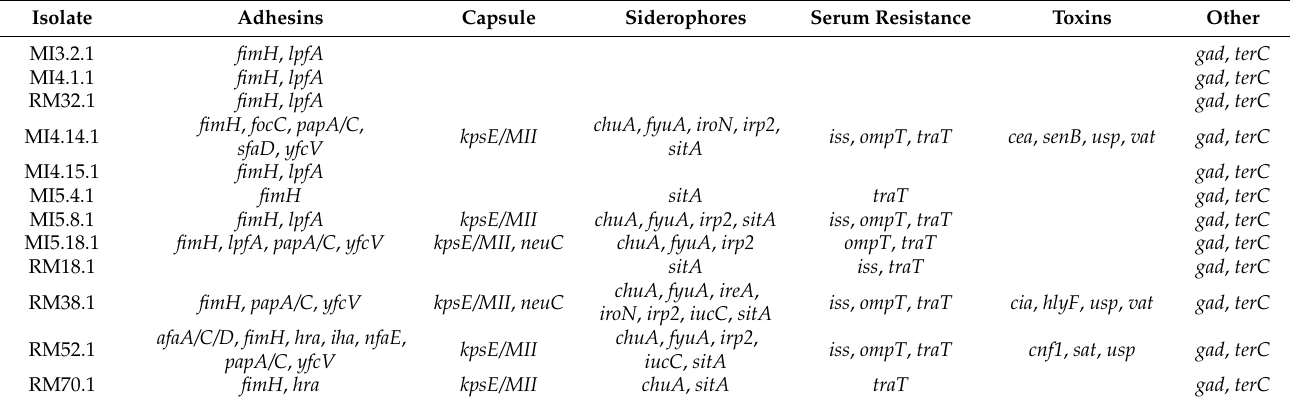
Table 2. Virulence gene content, according to their functions, of 12 CP- Escherichia coli isolates from carriage in elderly